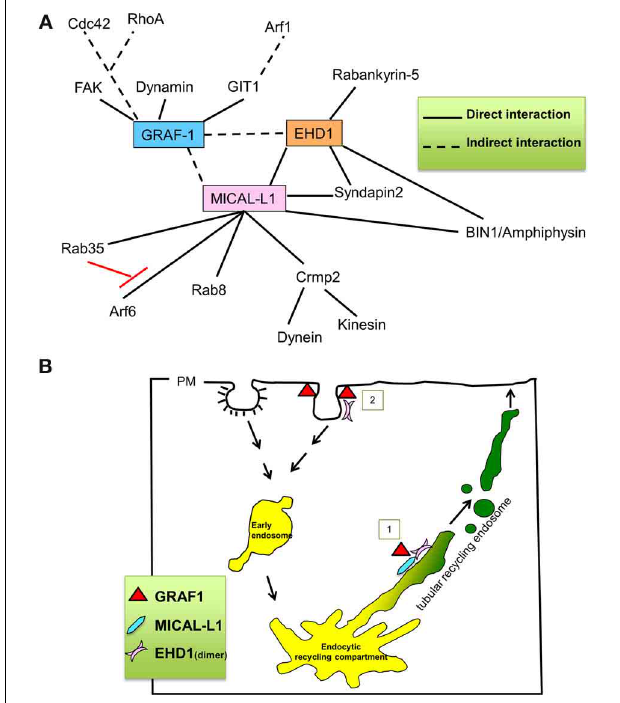
FIGURE 8 | Proposed role for GRAF1 in mediating vesiculation of tubular recycling endosomes. (A) Key interaction partners of GRAF1, MICAL-L1 and EHD1. (B) Proposed roles for GRAF1 and EHD1 at the plasma membrane, in the clathrin-independent endocytic pathway [pathway 2] [(Cai et al., 2011) and reviewed in Doherty and Lundmark (2009)], and for GRAF1, MICAL-L1 and EHD1 at tubular recycling endosomes [pathway 1]; MICAL-L1 is recruited onto TRE by directly binding to phosphatidic acid. It then recruits EHD1 by a direct interaction and interacts indirectly with GRAF1. EHD1, and GRAF1 then synergistically vesiculate TRE, giving rise to small and motile recycling